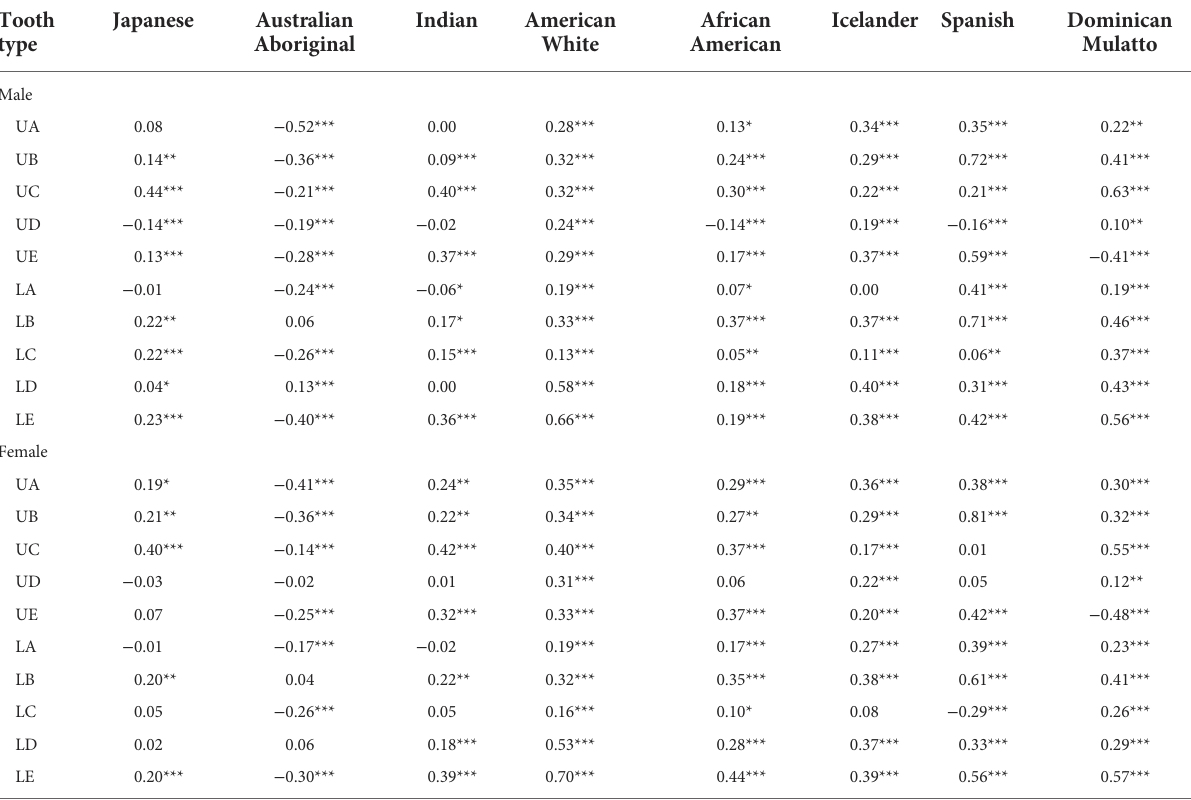
TABLE 9 Difference (mm) between the mesiodistal diameter of the primary teeth of northwest Chinese and those of the other populations. Tooth